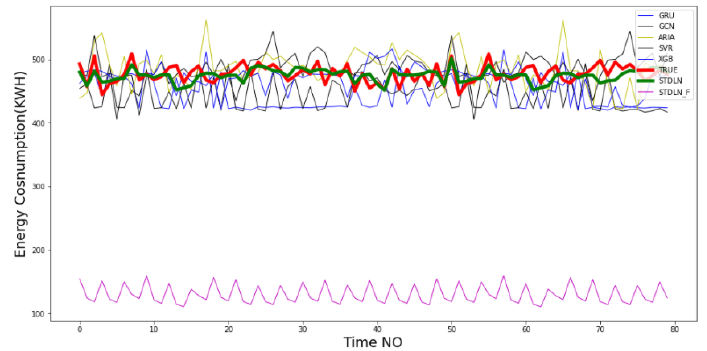
Figure 10. The continuous prediction of all methods for the 15 min set of Node XW3.